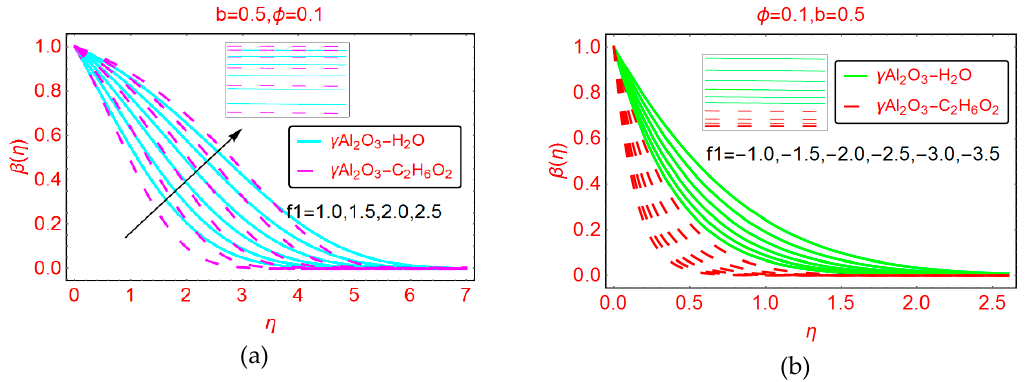
Figure 6. E ff ects of f 1 on the temperature profile β ( η ) for ( a ) f 1 positive and ( b ) f 1 negative. Figure 6. Effects of 𝑓1 on the temperature profile 𝛽(𝜂) for ( a ) 𝑓1 positive and ( b ) 𝑓1 negative